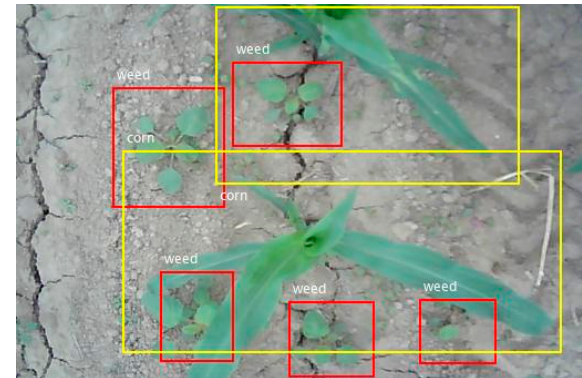
Figure 11. Experimental effect Ⅲ .